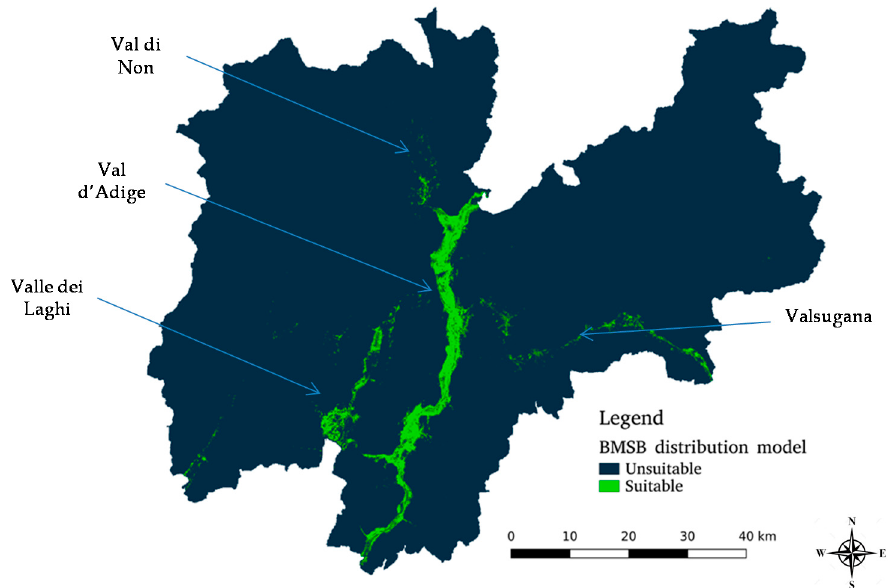
Figure 7. A suitability map of Trentino generated by MaxEnt, illustrating the areas suitable for the establishment of BMSB. ROC analysis was performed on the results of the 500 m sub-sampled model allowing the identification of the best cut-off value at 0.26 with a classification accuracy of 0.92. The logistic output of the map from MaxEnt was reclassified according to the best cut-off in two classes: unsuitable habitat below 0.26 of the logistic output and suitable habitat above that value.